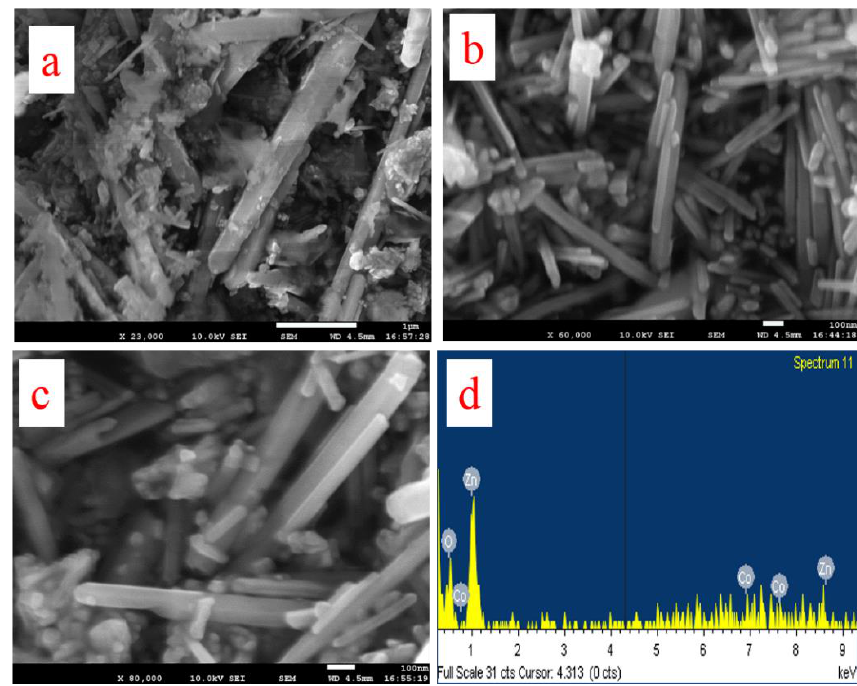
Figure 1. Morphological and elemental analyses. ( a – c ) FESEM images of Co 3 O 4 -ZnO. ( d ) XEDS spectrum of Co 3 O 4 -ZnO.